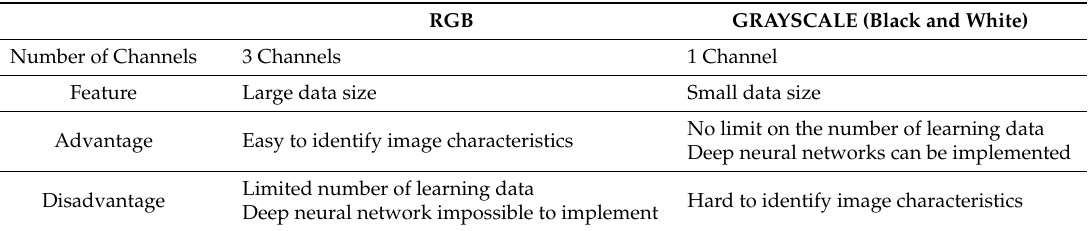
Table 3. Features of RGB, GRAYSCALE.